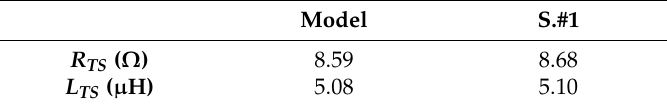
Table 4. Impedance of PCB antenna dedicated to the HF